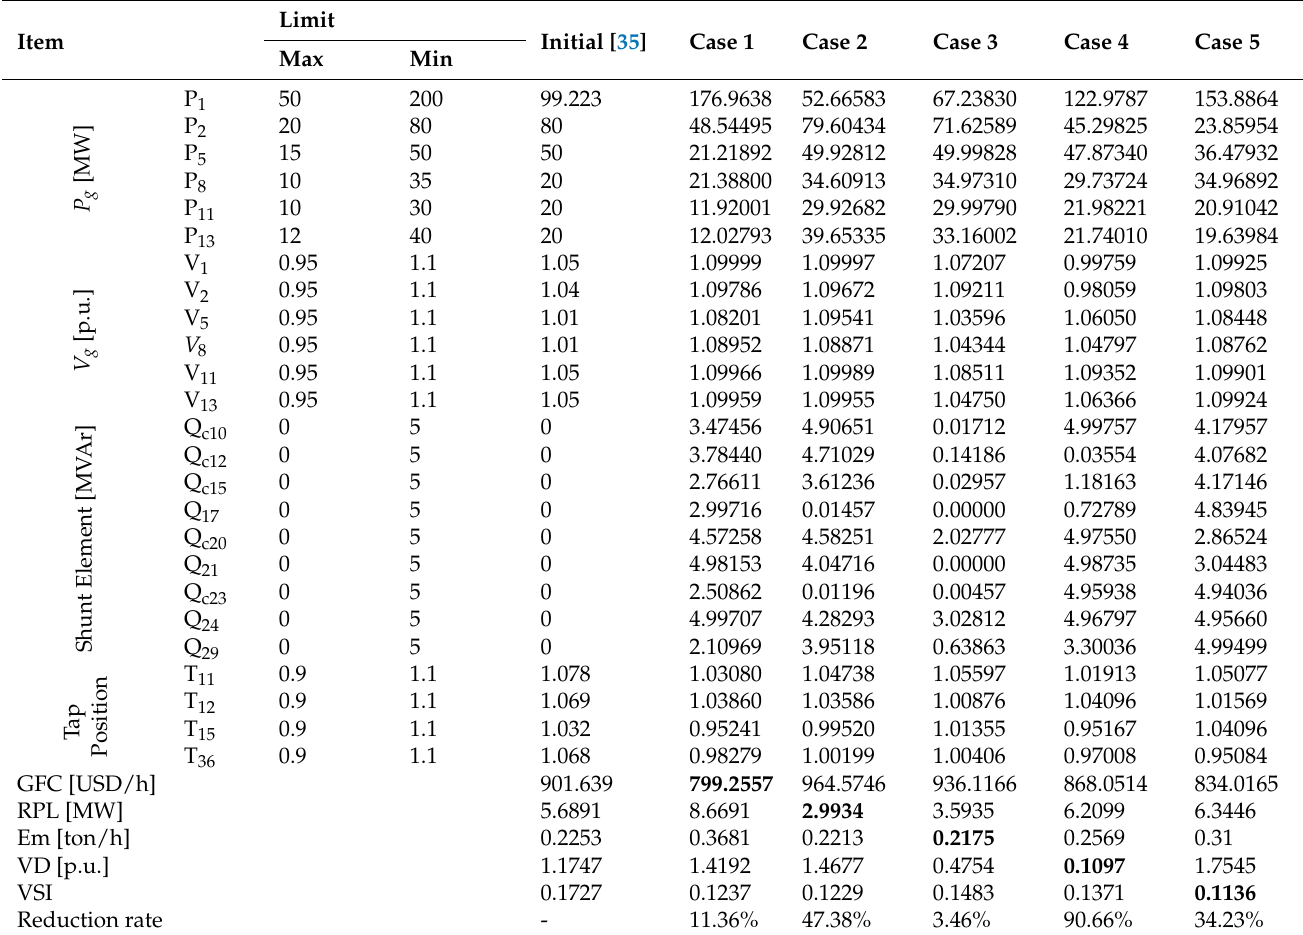
Table 3. Optimal control variables obtained by SMA for Cases